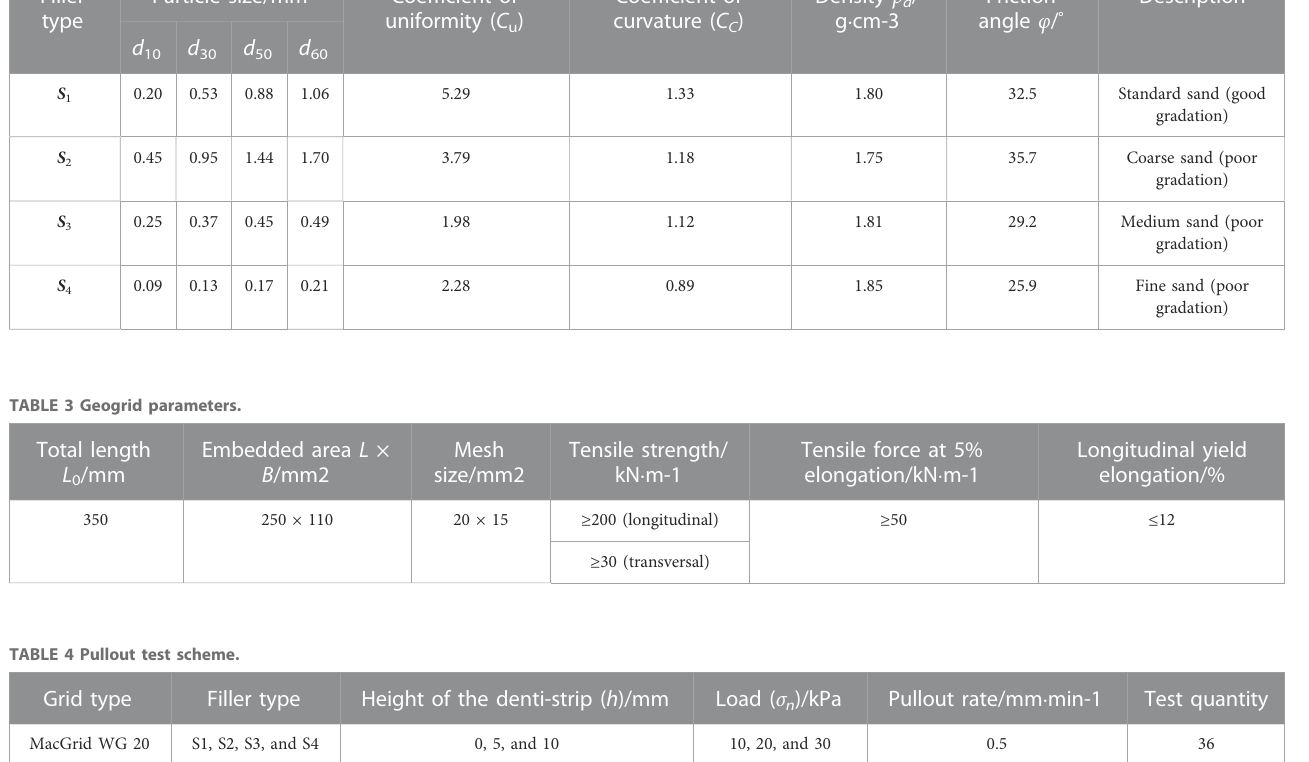
TABLE 2 Basic properties of fi llers.